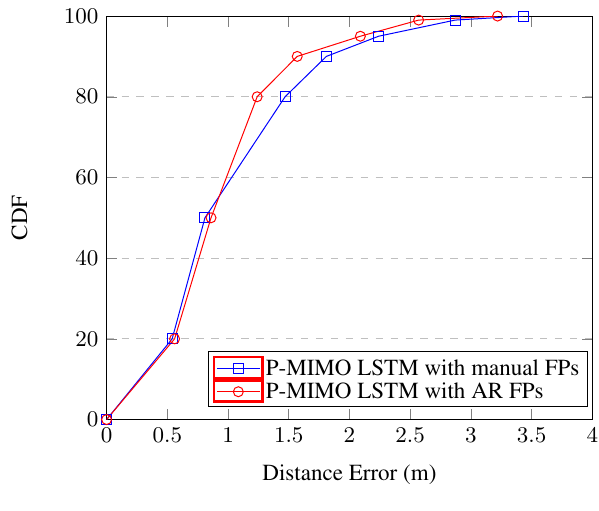
Figure 13. P-MIMO LSTM